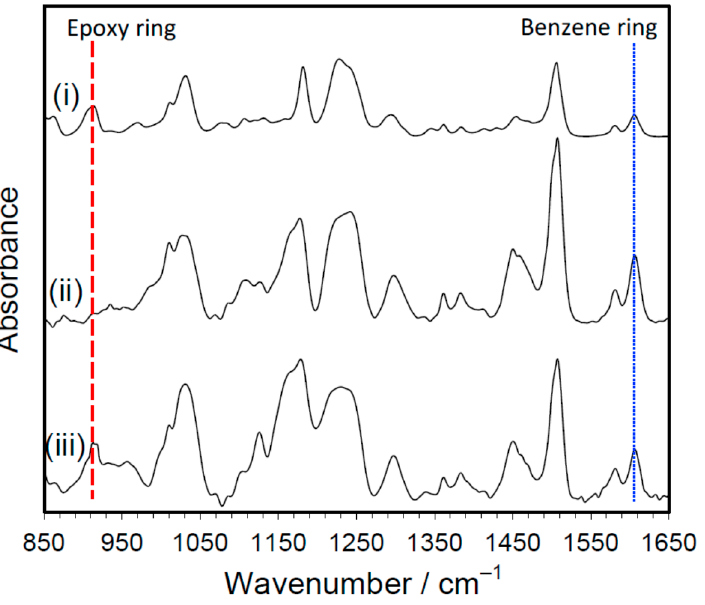
Figure 3. FT ‐ IR spectra of the cured (BADGE + PA + EM) adhesive by microwave heating and by conventional heating in an electric furnace: (i) before curing, (ii) after microwave curing for 10 min, (iii) after electric furnace curing for 20 min.